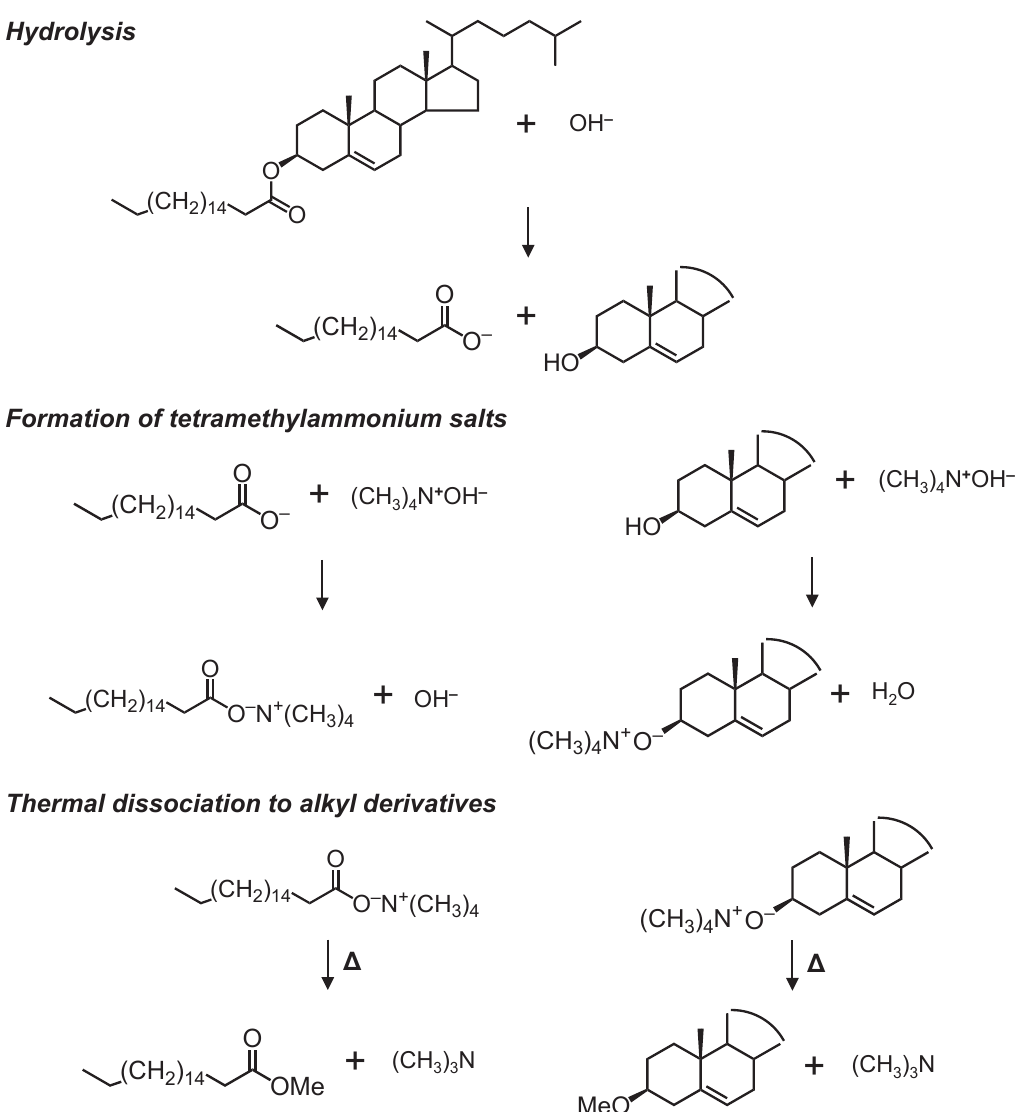
Figure 2. Generation processes for sterol methyl ether from cholesteryl stearate via the tetramethylammonium hydroxide (TMAH) reaction. This figure was drawn based on Asperger et al. [29] and Challinor